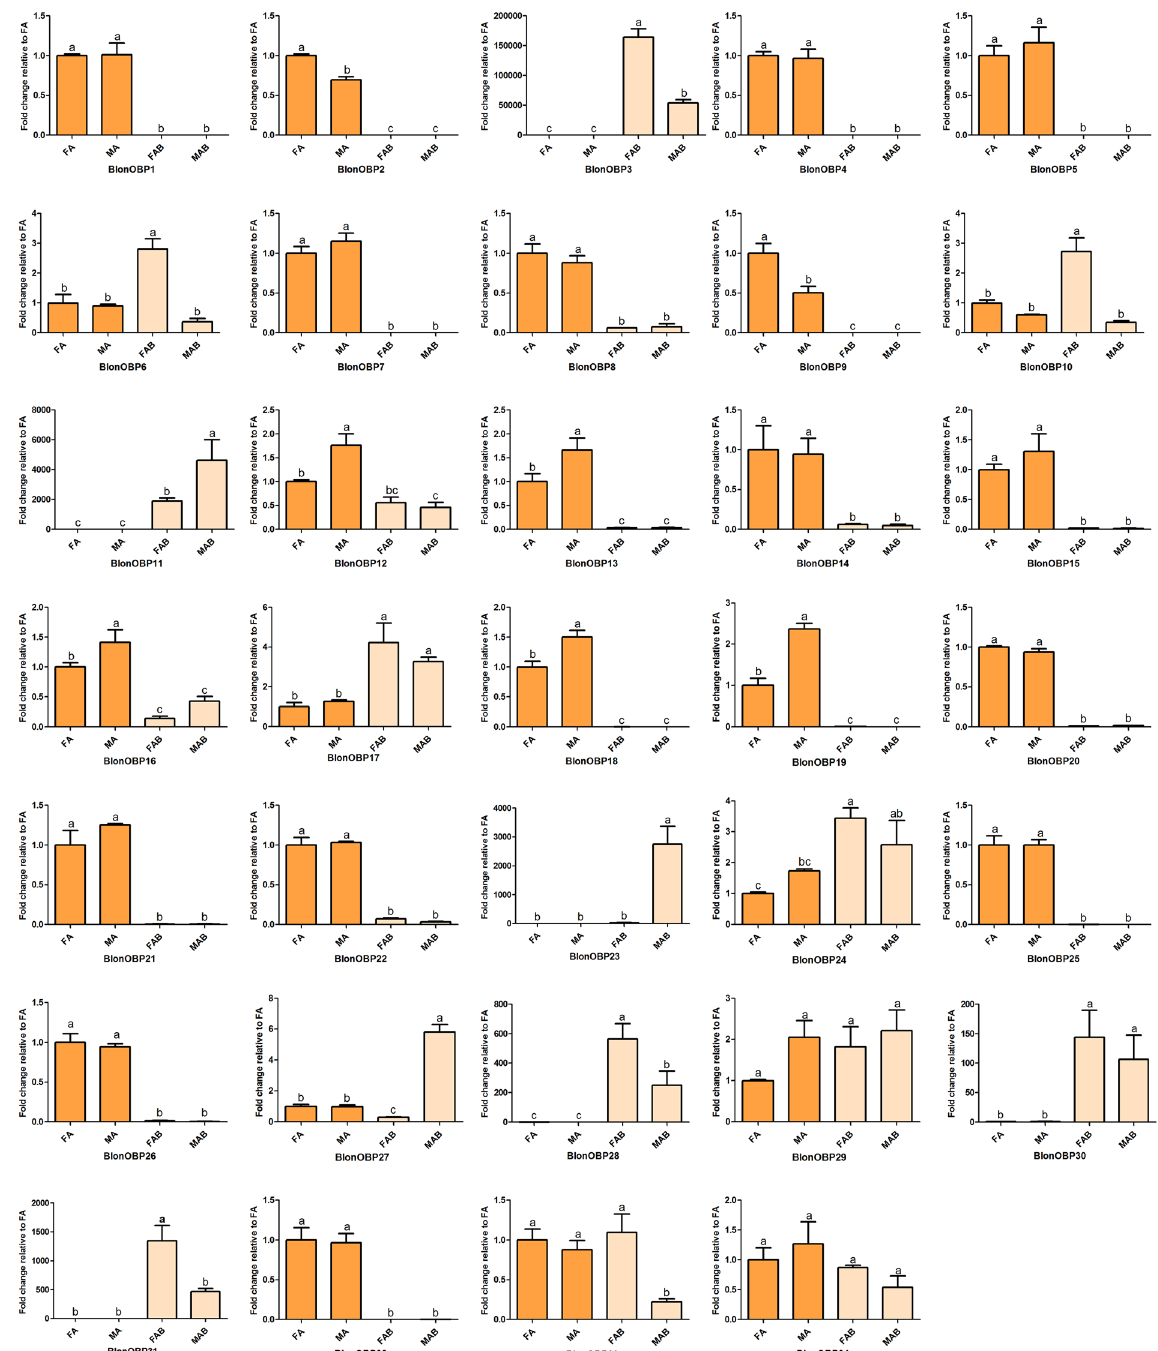
Figure 6. Relative expression levels of all OBPs in the four tissues, using qPCR. FA, female antennae; MA, male antennae; FAB, female terminal abdomens; MAB, male terminal abdomens. The relative expression level is indicated as mean ± SE (N = 3). Different letters indicate significant differences between tissues (P < 0.05, ANOVA,